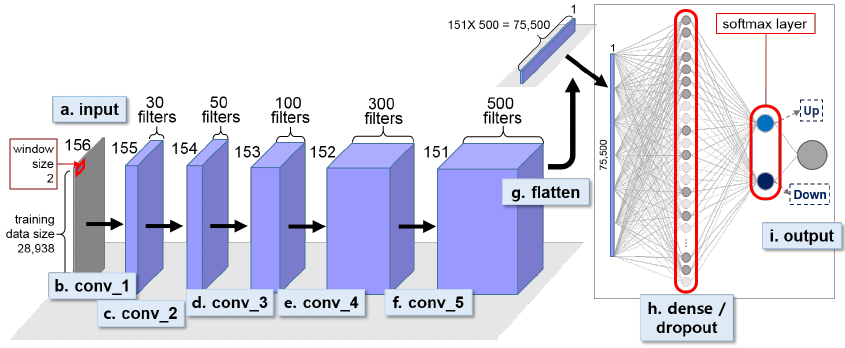
Figure 8. First-stage 1D CNN for classifying abstract activities, i.e., Up and Down, for OPPORTUNITY